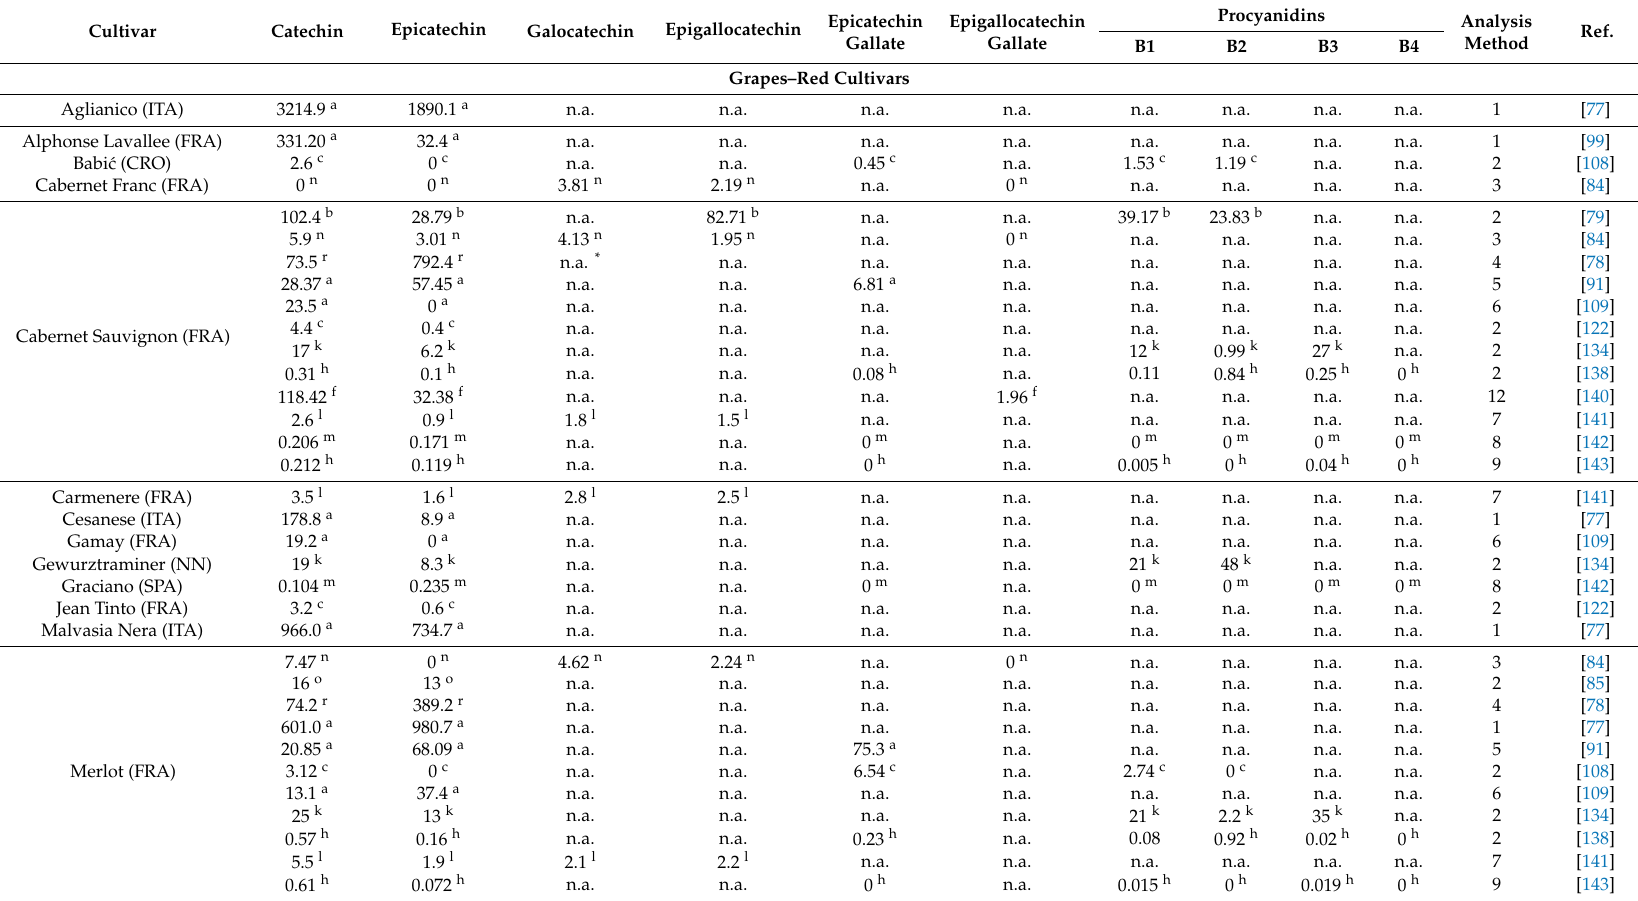
Table 6. Contents of flavan-3-ols in grapes of di ff erent grapevine